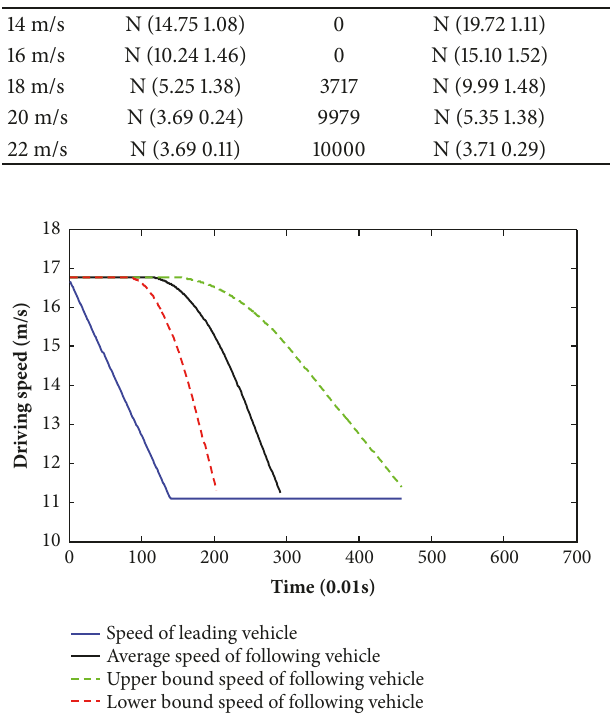
Figure 9: The distribution of driving speed (with a 95% confidence interval).